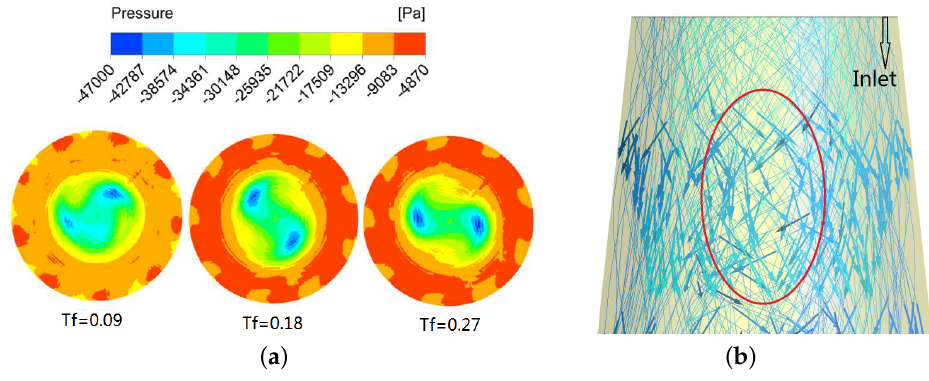
Figure 15. ( a ) Inlet gauge pressure distributions registered in the draft tube; and ( b ) representation of the straight cone streamlines in the draft